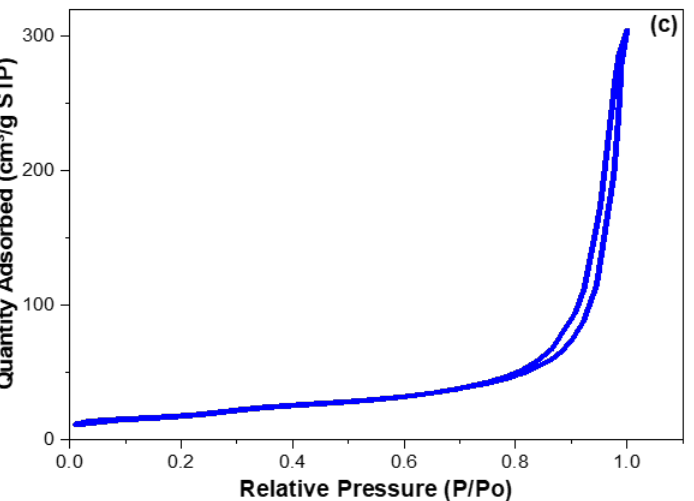
Figure 9. ( a ) Adsorption of TGCN, DXCN, CTCN, and OTCN on CRNPs from contaminated GS and SS; ( b ) the removal efficiency for TGCN, DXCN, CTCN, and OTCN by the regenerated CRNPs. ( c ) The surface area reduction to 200 m 2 g −1 for the regenerated CRNPs.